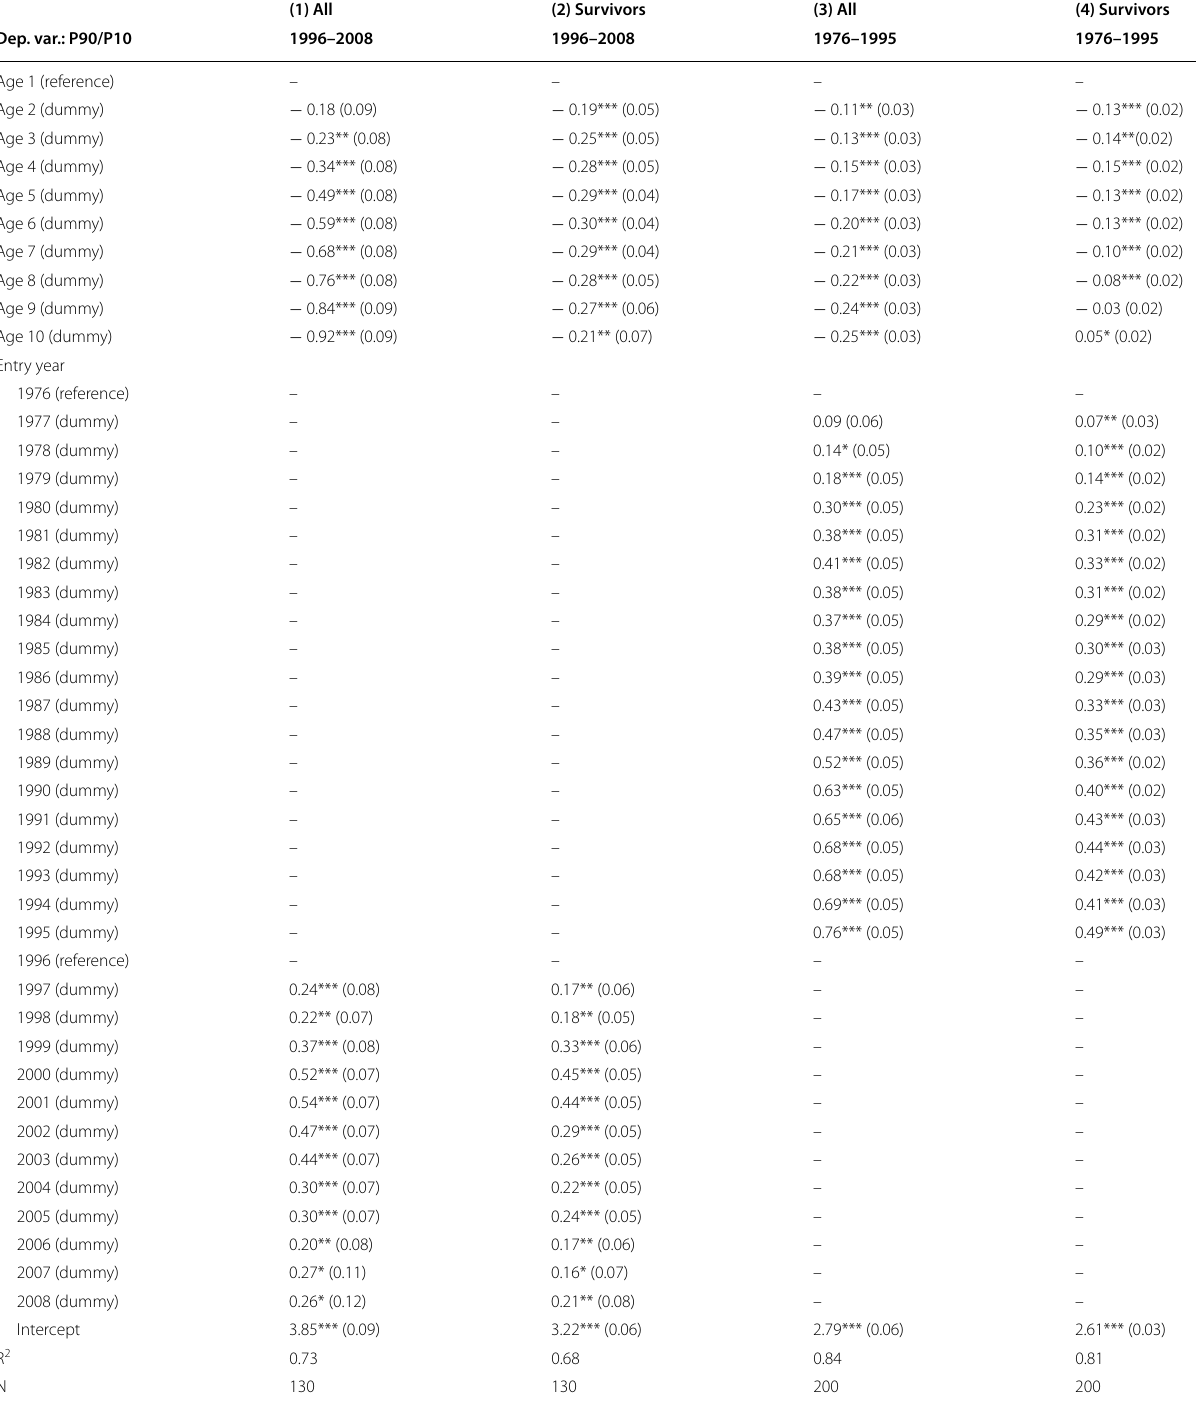
Table 5 Within- and between-cohort wage dispersion with alternative